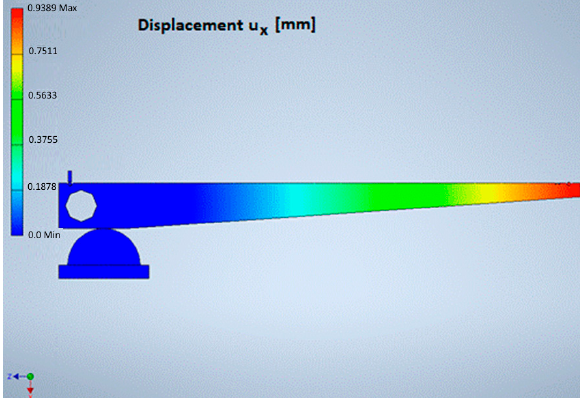
Figure 18. Tilt arm displacements along the X axis when loaded with 30 N and in contact with the material sample.